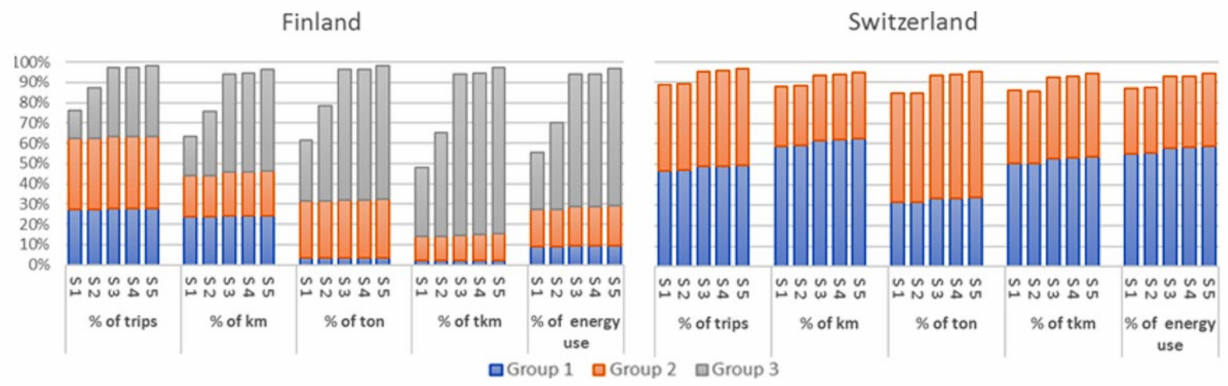
Figure 3. Comparative chart of manageable successful trips for various payload groups in Finland and